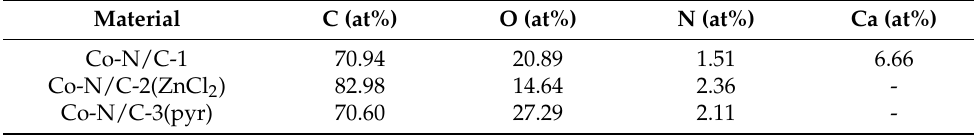
Table 2. Elemental composition (at%) of selected materials obtained by XPS.